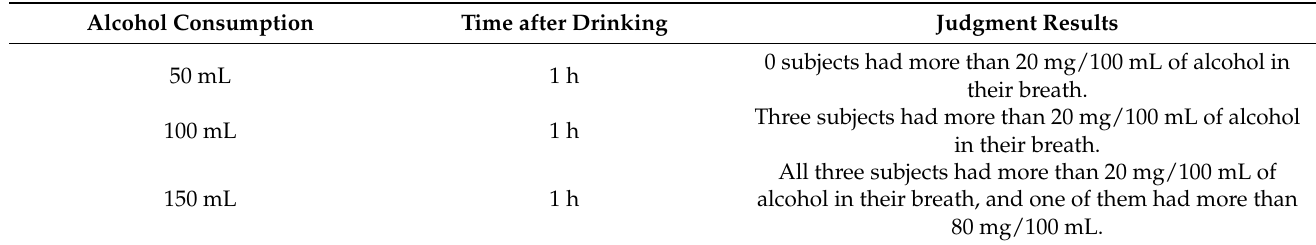
Table 5. Driver drinking judgment